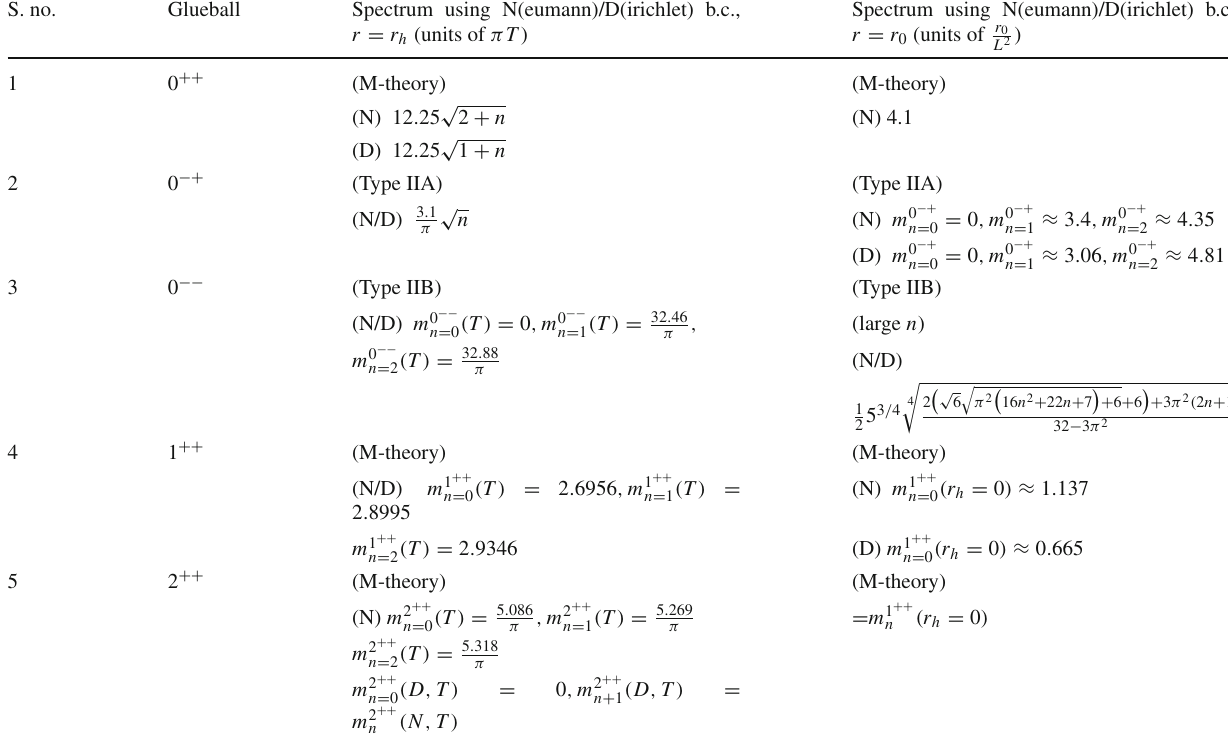
Table 3 Summary of glueball spectra from Type IIB, IIA and M Theory for r h (cid:10)= 0 / r h = 0 using Neumann/Dirichlet boundary conditions at the horizon r h /IR cut-off r 0 S.